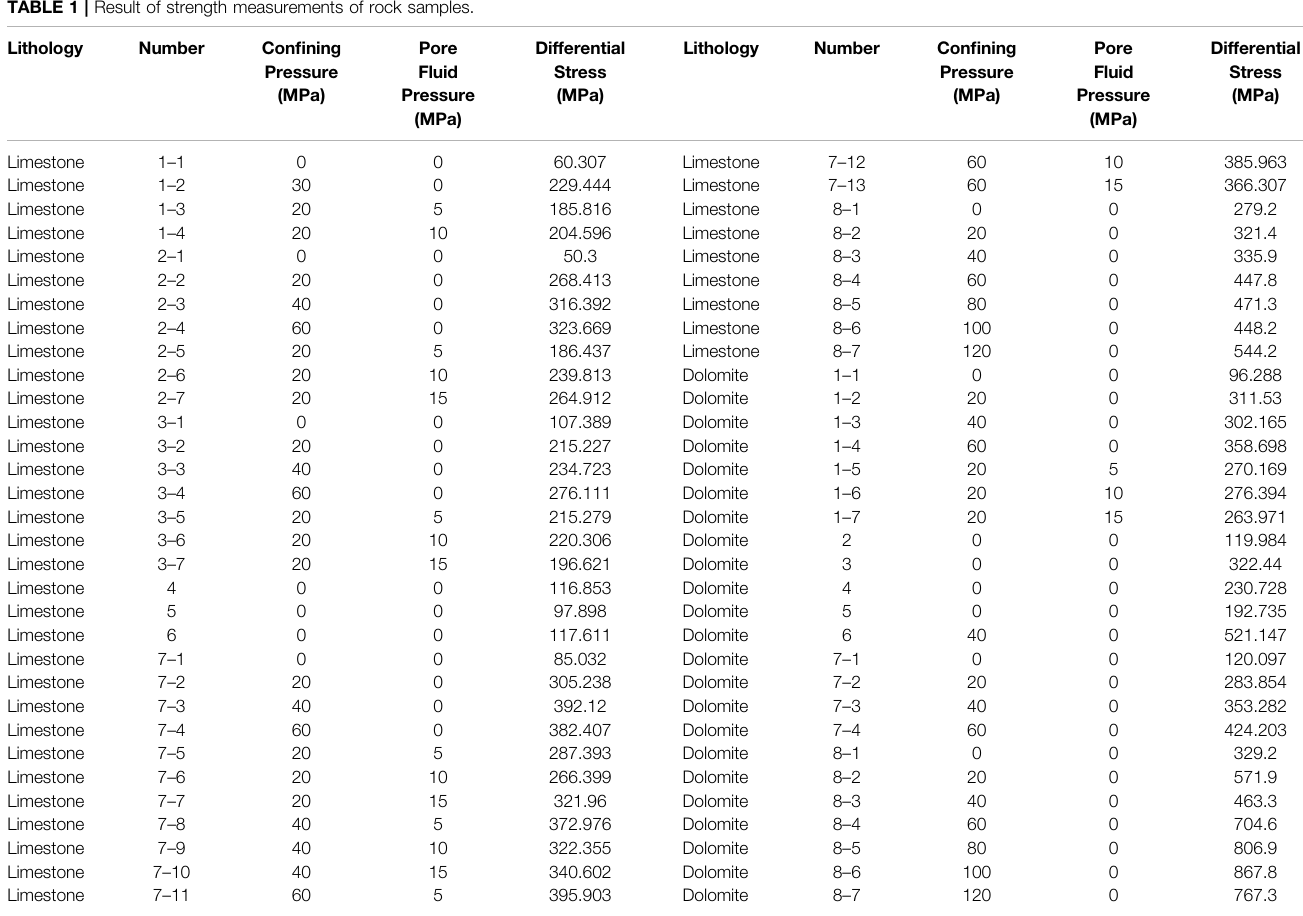
TABLE 1 | Result of strength measurements of rock